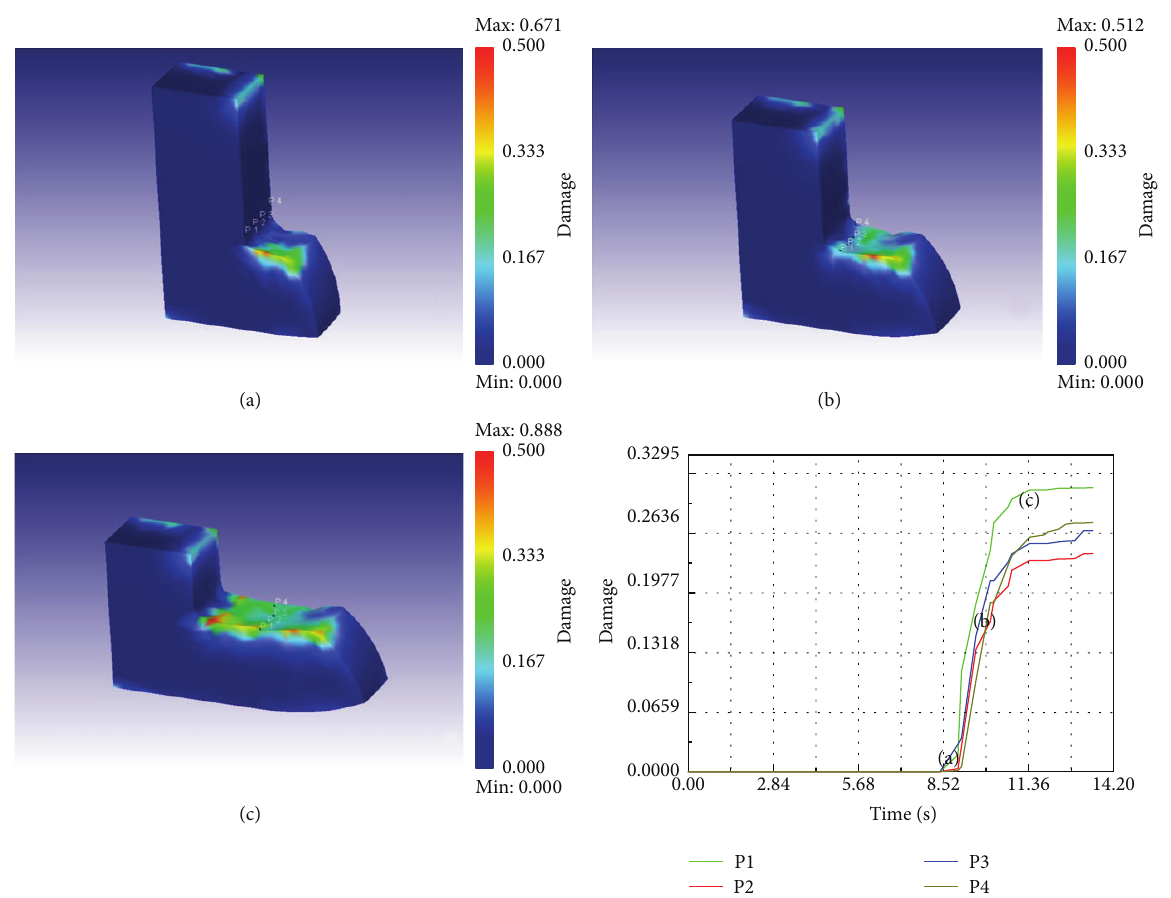
Figure 5: The different damage factor distribution in three stages during the extrusion processing. (a) Time is 8.52, (b) time is 9.94, and (c) time is 11.36.